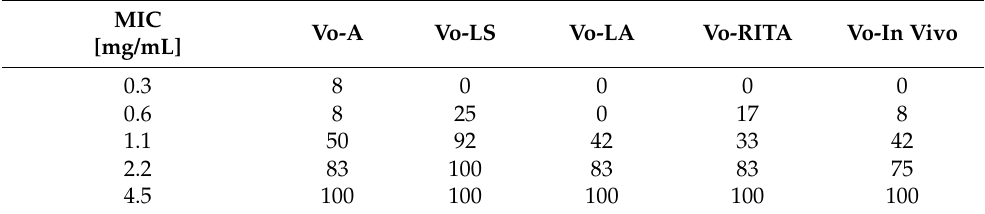
Table 6. Percentage of antibacterial activity (A%) of extracts of V. officinalis in vitro cultures; agar (Vo-A), stationary liquid (Vo-LS), agitated (Vo-LA) and bioreactor cultures (Vo-RITA) and of plant material (Vo-in